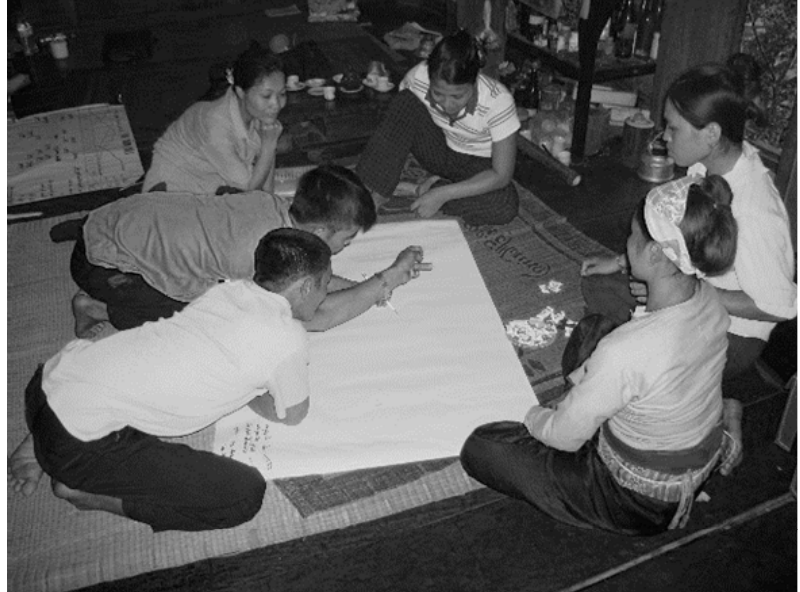
Figure 2. Deliberation among Vietnamese researchers in the LLINC-project.